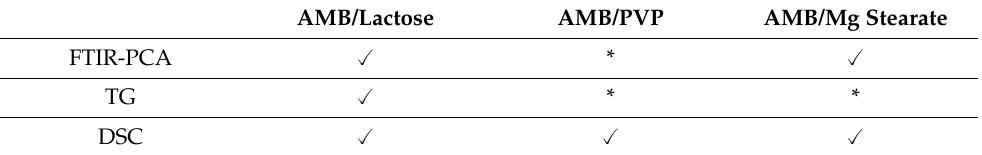
Table 6. The comparative analysis of compatibility study performed on AMB and FT